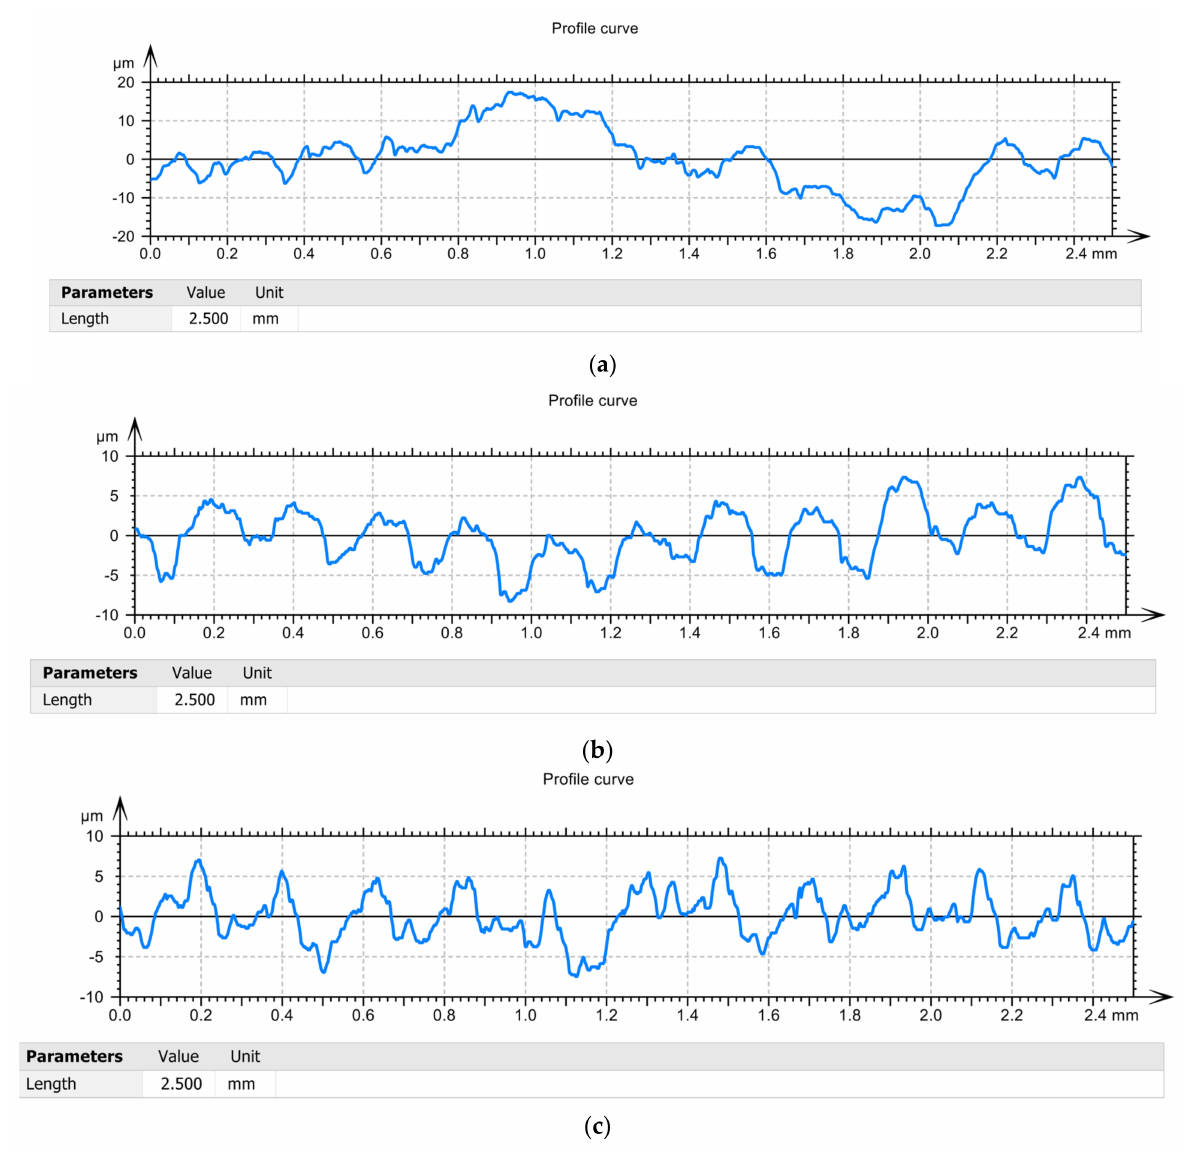
Figure 12. Profile curve: ( a ) in the case of machining with a T01 cutting tool; ( b ) in case of machining with T02 cutting tool; ( c ) in case of machining with cutting tool T03.